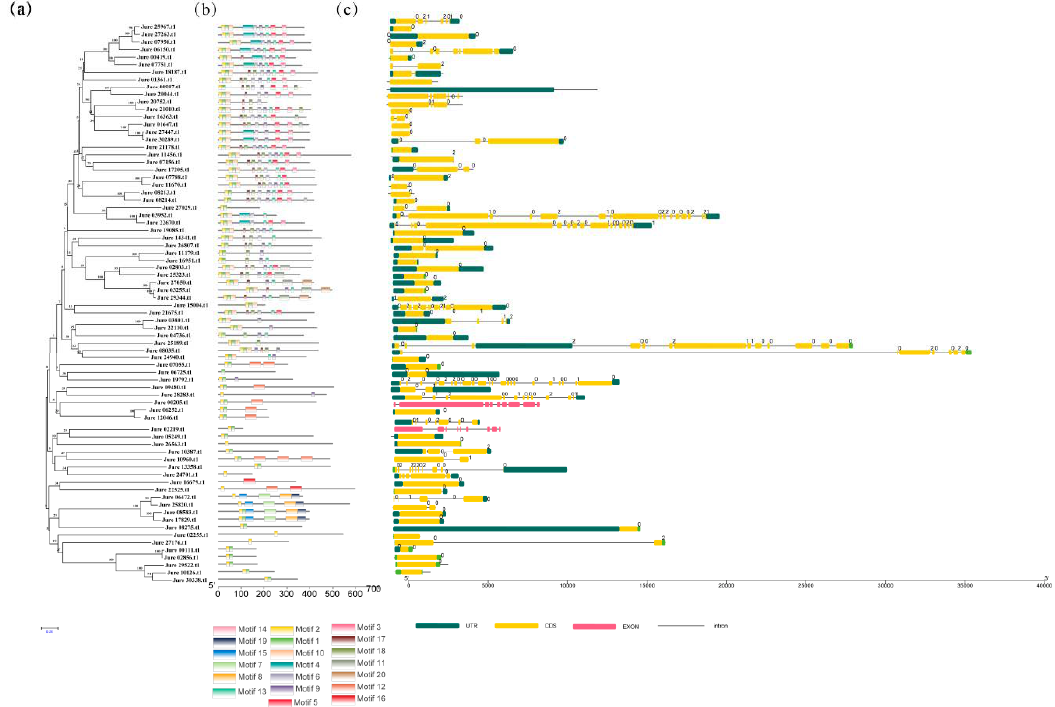
Figure 3. ( a ) Phylogenetic relationships, ( b ) motif compositions, and ( c ) gene structures of the 74 F-box genes identified in common walnut. ( a ) Phylogenetic relationships used the NJ method, and different colors represent different groups. ( b ) Colored boxes indicate conserved motifs, and gray lines represent non-conserved sequences. The length of motifs in each protein is shown proportionally. ( c ) UTR represents upstream, CDS represents coding sequence, and EXON represents exon; 0, 1, and 2 represent different types of phase. Phase 0: located between two consecutive codons; Phase 1: splitting codon between the first and second nucleotides; Phase 2: between the second and third nucleotides of a codon.